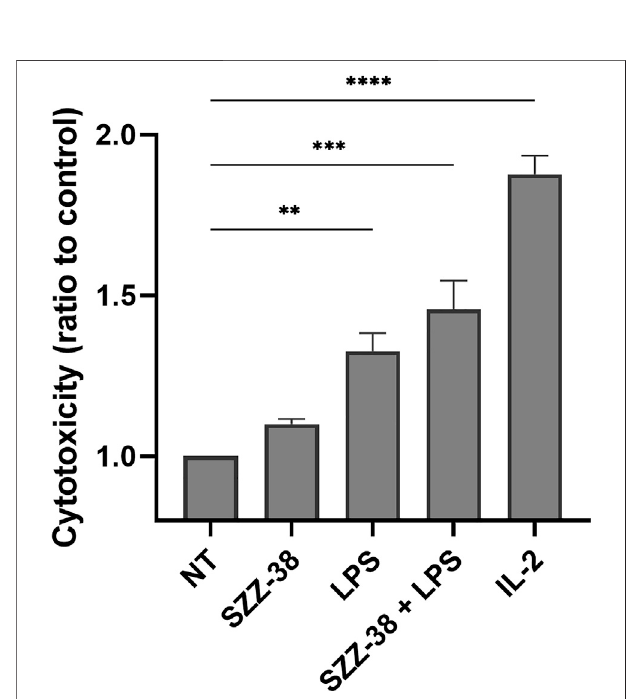
FIGURE6 | Effect ofSZZ-38 and LPS onthe cytolytic activity of NK cells againstK562cells.IsolatedNKcellsweretreatedfor18 hwithSZZ-38(1 µM), LPS (1 µg/mL), their combination, or IL-2 (200 IU/mL) before the addition of K562 cells. Cytotoxicity was determined after 4 h of co-incubation. Data are shown relative to the negative control (0.1% DMSO) and expressed as means ± SEM of three independent experiments. Statistical signi fi cance was determinedbyDunnet ’ smultiplecomparisonstest;**, p < 0.01,***, p <